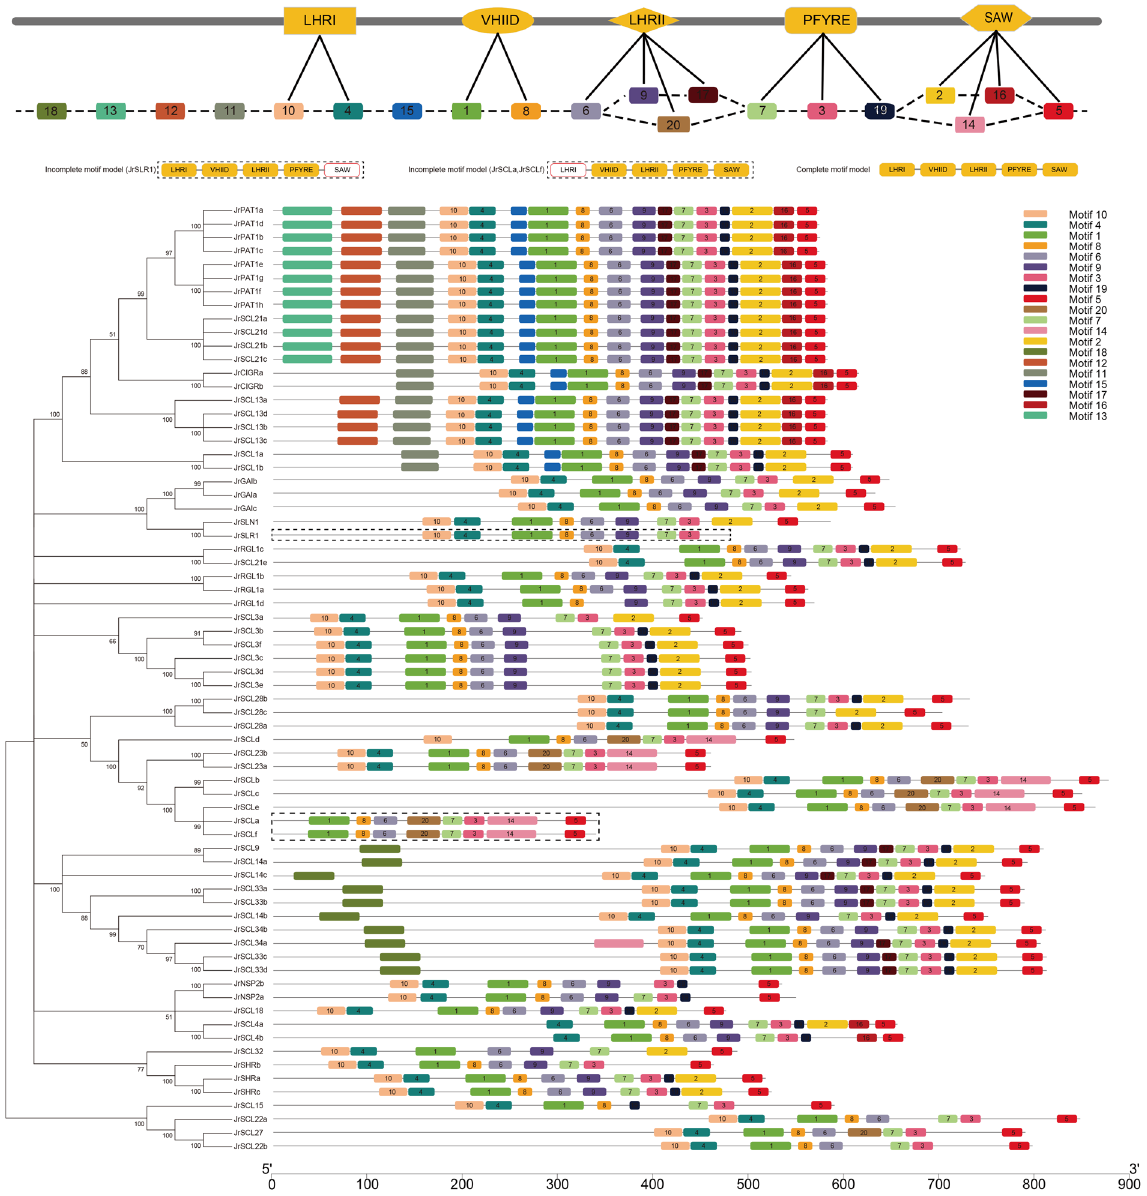
Figure 3. Phylogenetic relationship, motifs and gene structures of GRAS members in